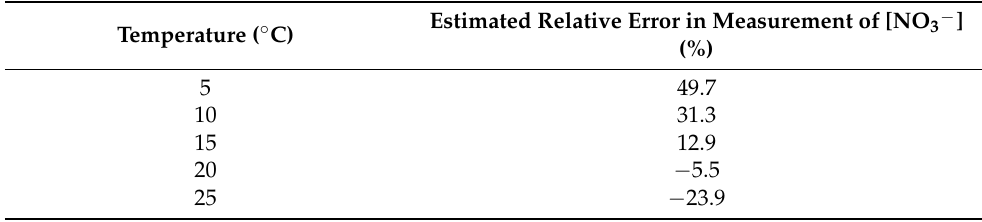
Table 2. Estimated relative error of [NO 3 − ] measurement at 5, 10, 15, 20 and 25 ◦ C when using the ISE meters. Error values were derived the equation y = − 3.68x + 68.1 for combined data set of all measurements (both ISE meters, all NO 3 − sources, all [NO 3 − ]) for the temperature range 5–25 ◦ C. Estimated Relative Error in Measurement of [NO 3 − Temperature ( ◦ C)